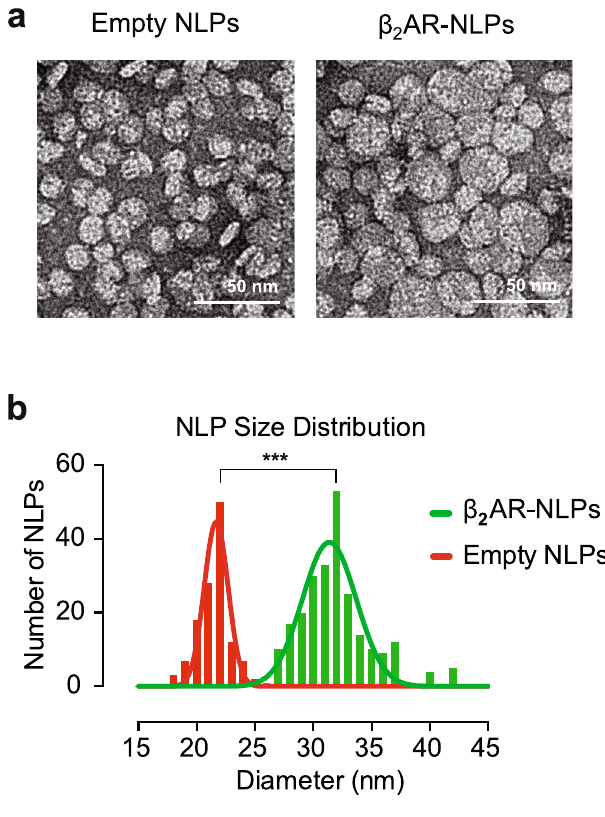
Figure 2. Transmission Electron Microscopy (TEM) characterization of β 2 AR-NLPs. TEM images of stain- embedded empty NLPs with average diameter of 21.5 nm and β 2 AR-NLPs with average diameter of 23 nm. Scale bar: 50 nm. (c) Particle size distribution of empty and β 2 AR-NLPs from TEM data. Standard deviation for empty and beta-adrenergic NLPs are 1.4 and 3.0, respectively (p < 0.0001, paired t